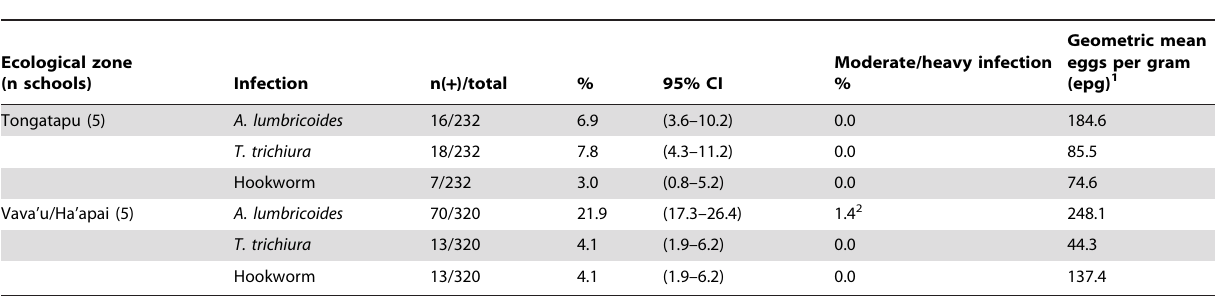
Table 7. Tonga STH infection species and